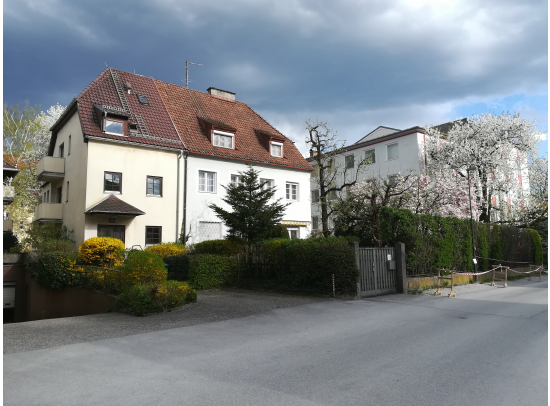
Figure 4. Example building used for densifica- tion consultation during “BONSEI!” (source: project